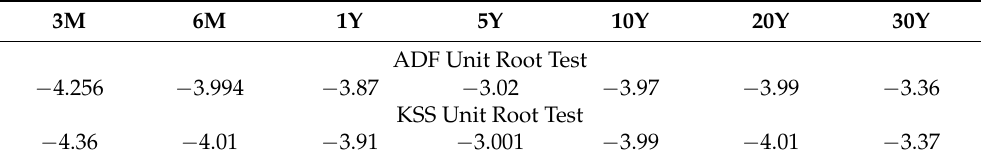
Table 2. Unit root tests.